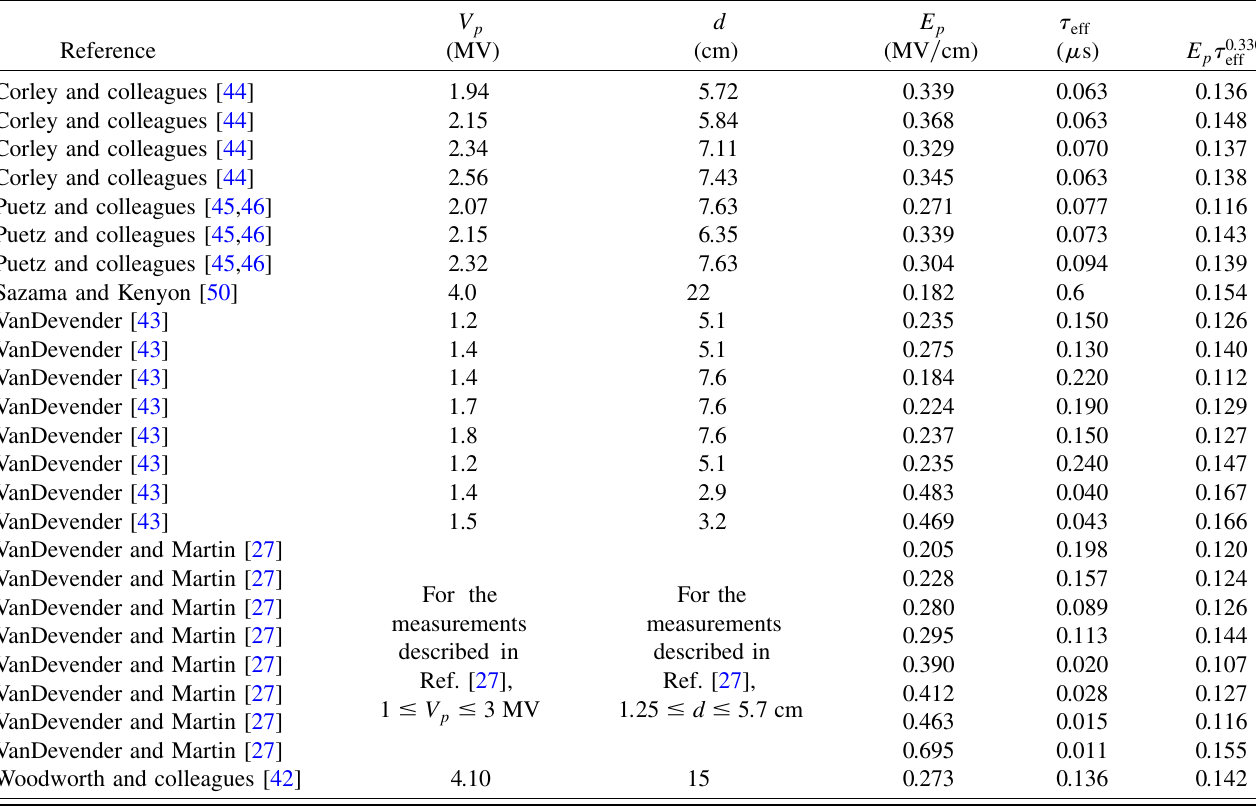
(cid:3) V =d , and (cid:1) is the temporal width of the p p eff in (cid:2) s . eff